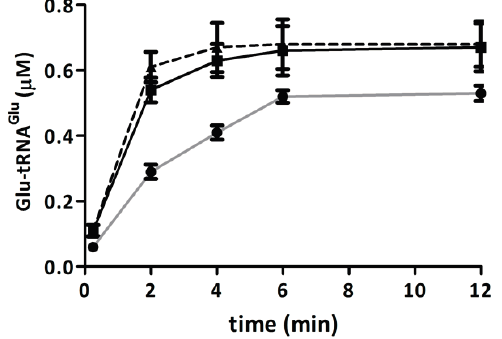
Figure 5. Activity of GluRS1 in presence of EF-Tu. The aminoacylation of tRNA 2Glu catalyzed by GluRS1 was determined in the absence ( ● ) or presence of EF-Tu, treated with 500 μ M H 2 O 2 ( ▲ ) or untreated ( ■